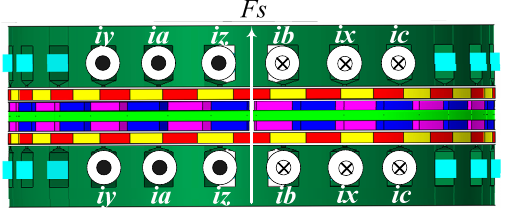
Figure 7. Initial position of the resultant magnetic field produced by the stator winding.